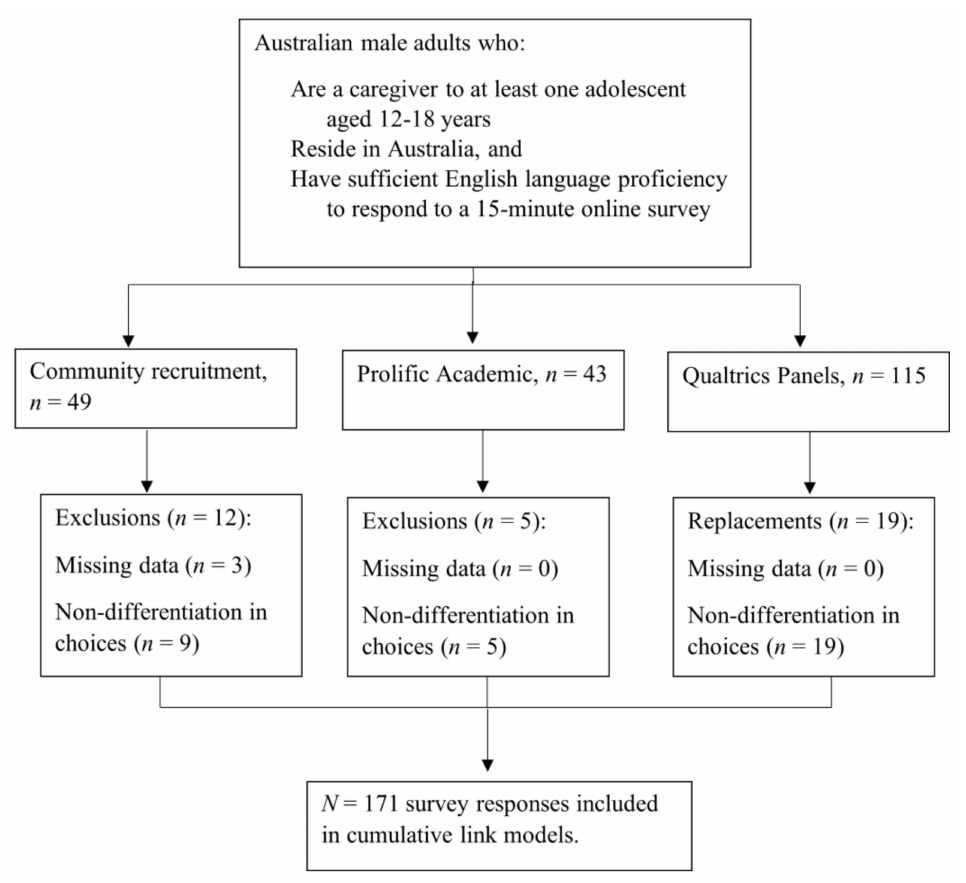
Figure 2. Participant flow and reasons for